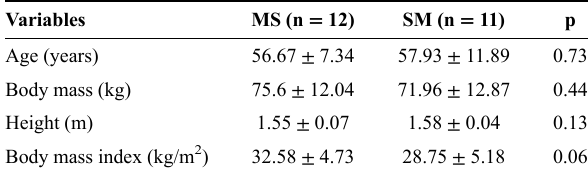
Table 1 - General characteristics of the